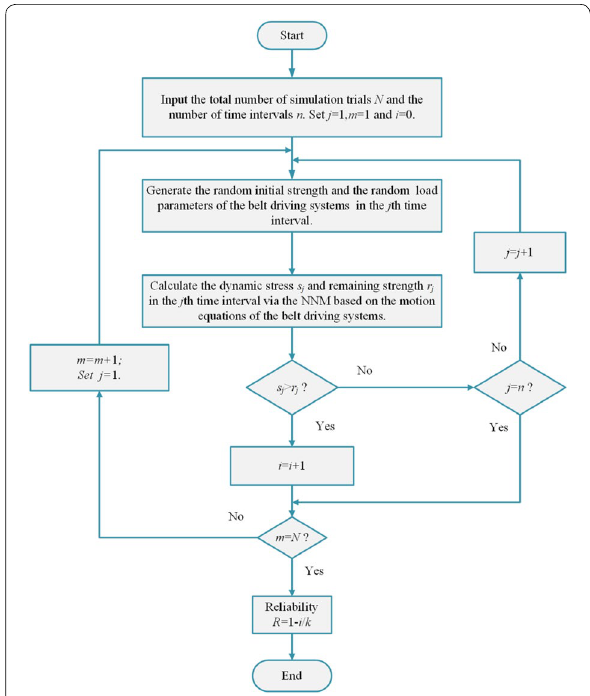
Figure 8 Monte Carlo simulation flow